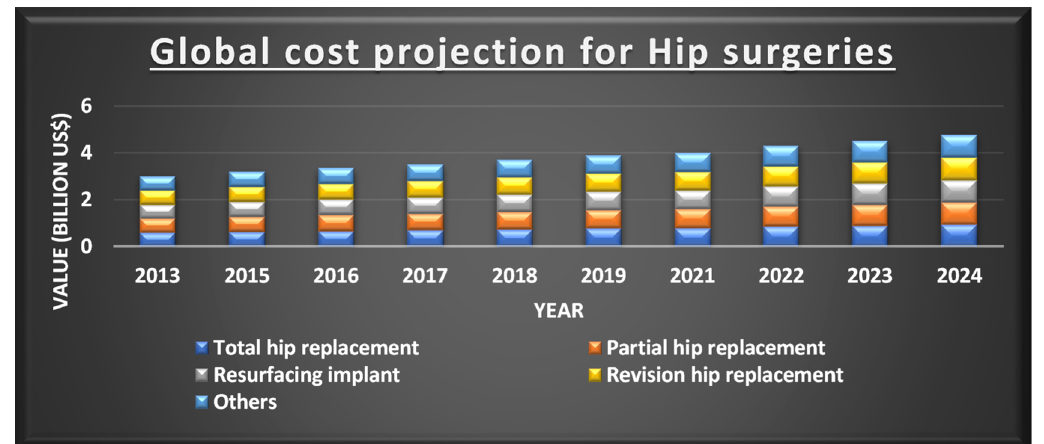
Figure 2. Projection of the cost for different types of hip implants. Reprinted from Ref [11]. Copyright 2019, Polaris Market Research.